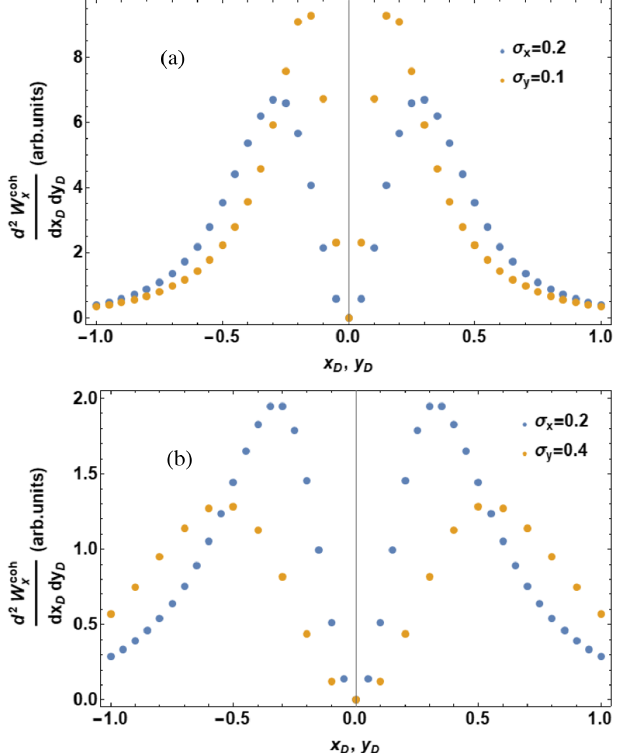
FIG. 14. Central cut through 2 – dimensional asymmetric COTR distributions shown in Fig. 13: (a) corresopnds to the Fig. 13 top one, (b) corresponds to the bottom one. Yellow points correspond to the y D and blue ones to the x D